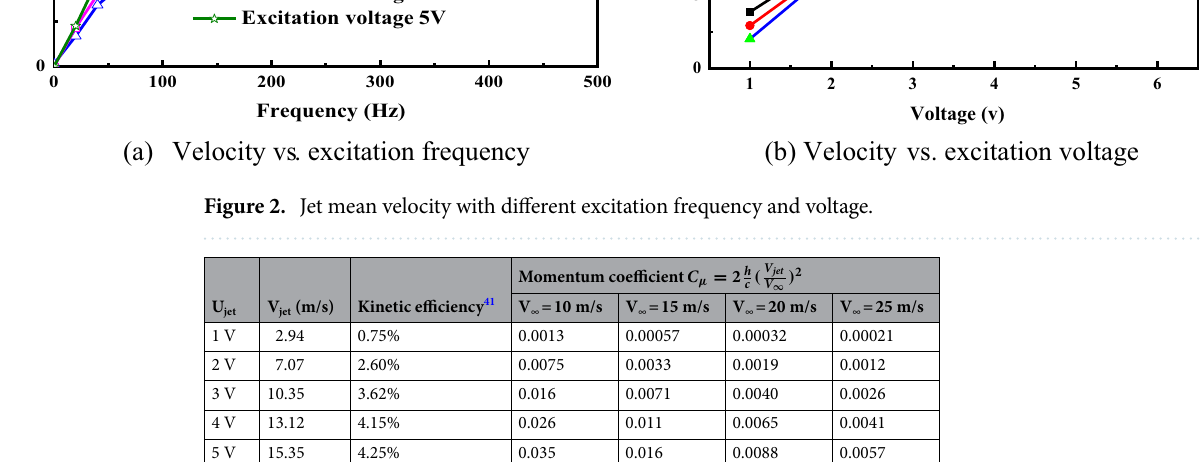
Table 1. Jet mean velocity and momentum coefficient with different excitation voltage and freestream.